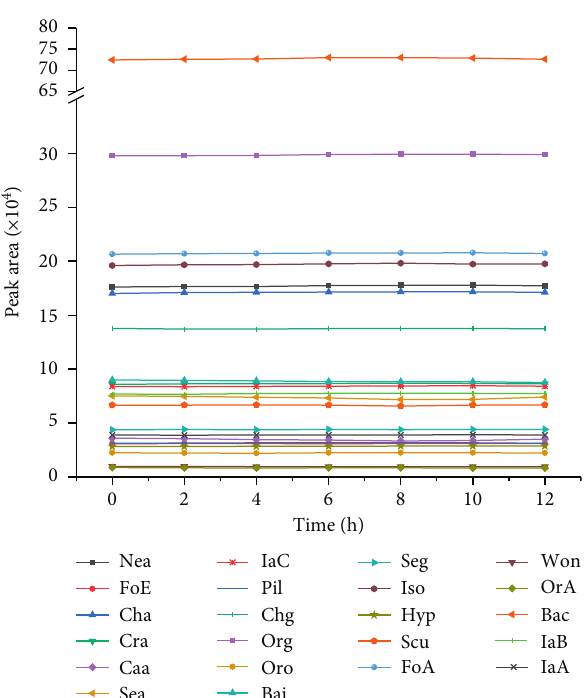
Figure 4: The stability study of tested compounds in sample solution during